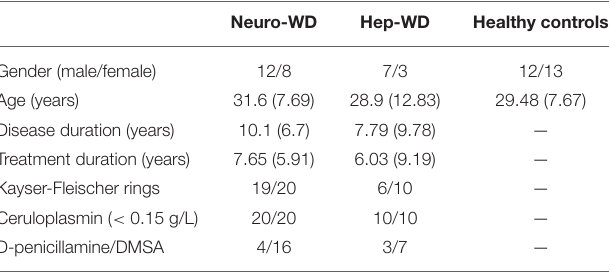
TABLE 1 | Demographic and clinical characteristics of patients with WD and healthy